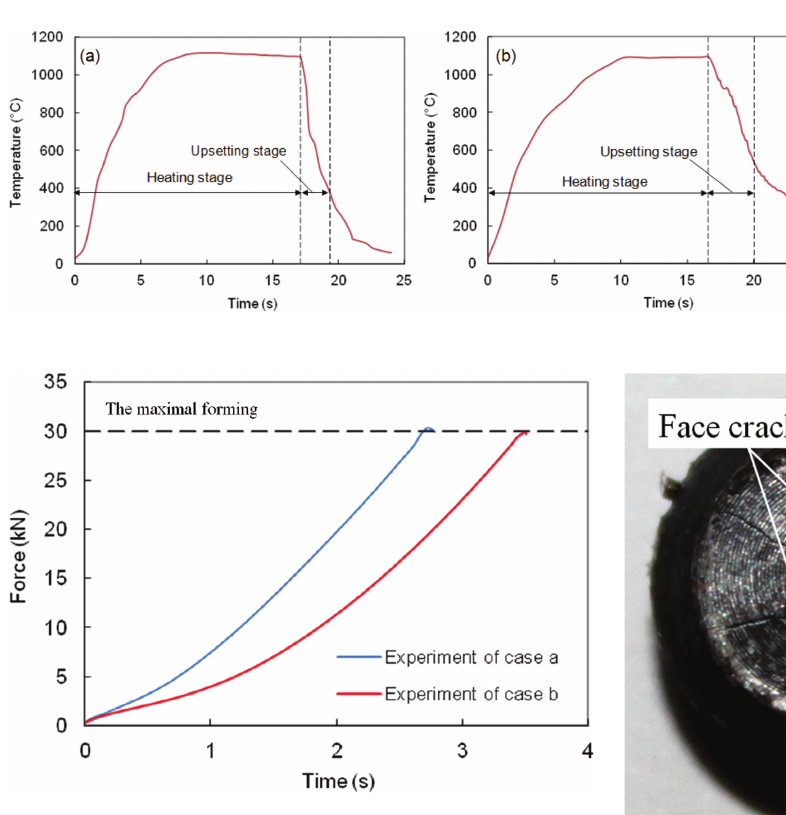
Figure 7: Forming time and forming force of different cases.